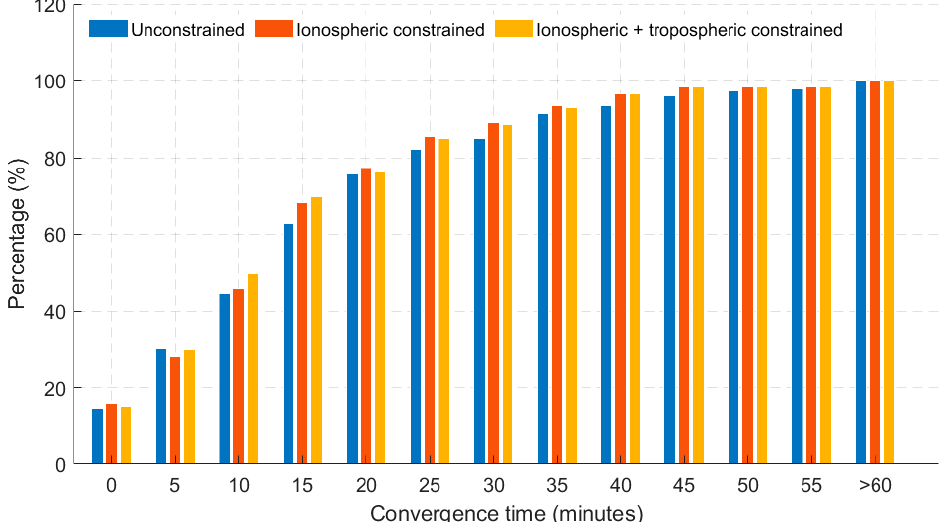
Figure 8. Histogram showing percentage of 40 stations converging based on 24 hourly solutions in triple-frequency GREC processing mode. Results shown have a 20 cm horizontal error threshold.